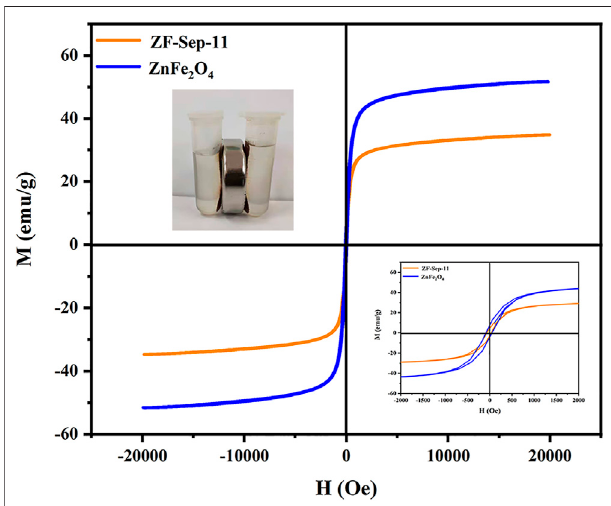
FIGURE 8 | Magnetization curves of ZnFe 2 O 4 and ZF-Sep-11, inset show zoomed in version and the situation with an external magnetic fi eld.